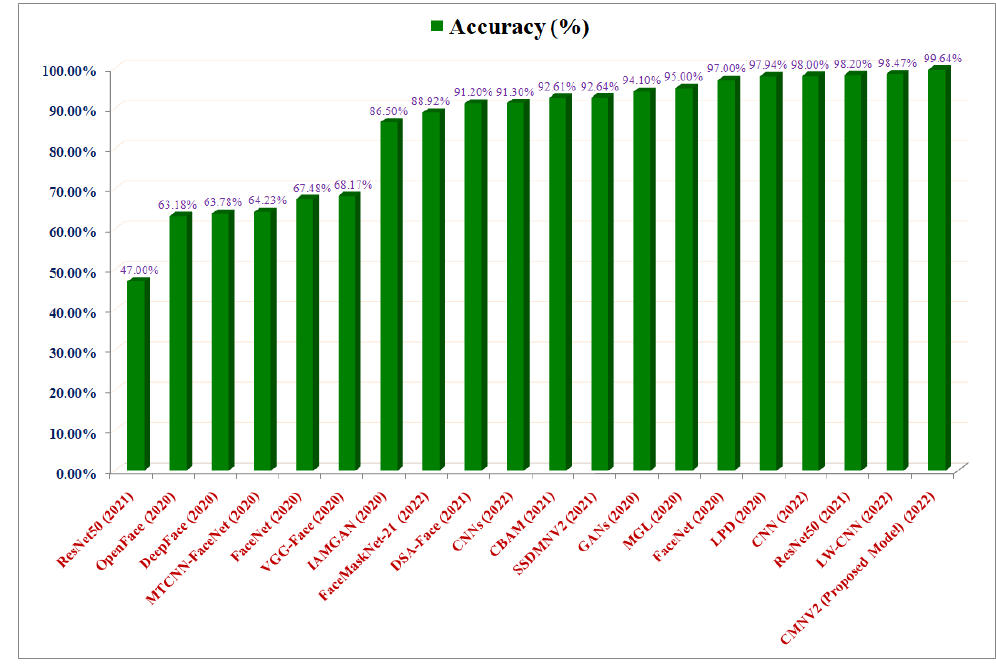
Figure 14. Comparison graph of various models’ accuracy. Table 5. Comparison of various models’ parameters and total